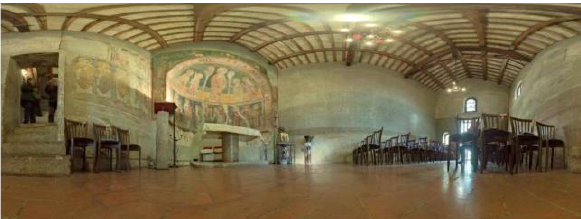
Figure 9- Santa Passera Church. A Panono